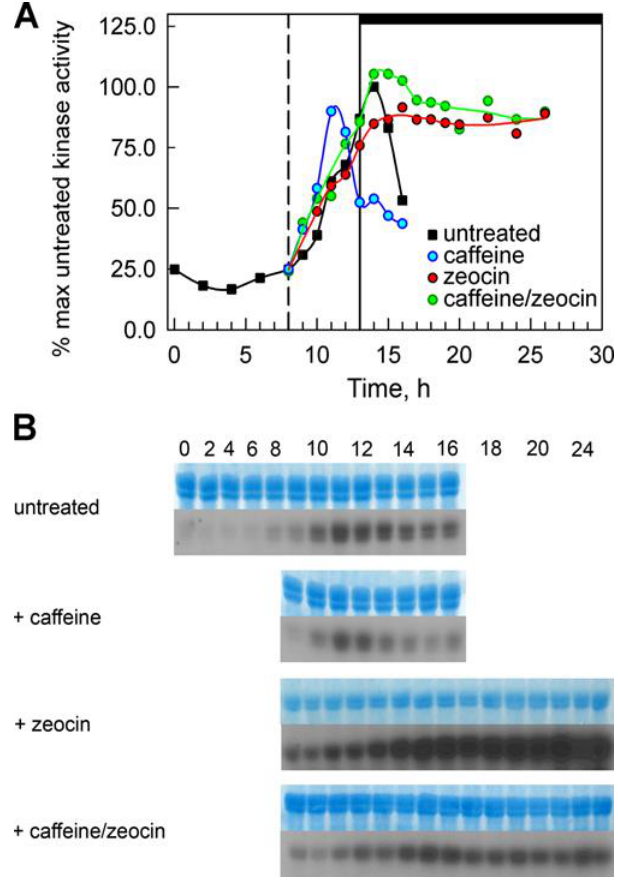
Figure 7. Kinase activities of CKS1-bound kinases CDKs were purified on CrCKS1 beads from cells grown in the absence or presence of caffeine, zeocin and caffeine/zeocin. Kinase activities towards histone H1 as a substrate are shown. ( A ) Means from at least four independent experiments are presented. ( B ) A representative image from one experiment is shown. Upper panel: gel stained by Coomassie Brilliant Blue for loading control, bottom panel: autoradiogram; the time of sampling in hours is depicted on the top of panels.